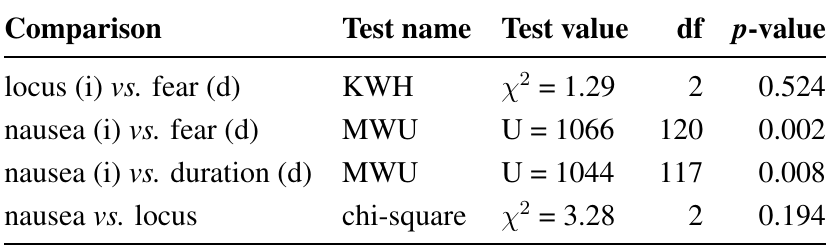
Table 2. Comparison of nausea groups, fear, locus of fear, and duration of fear